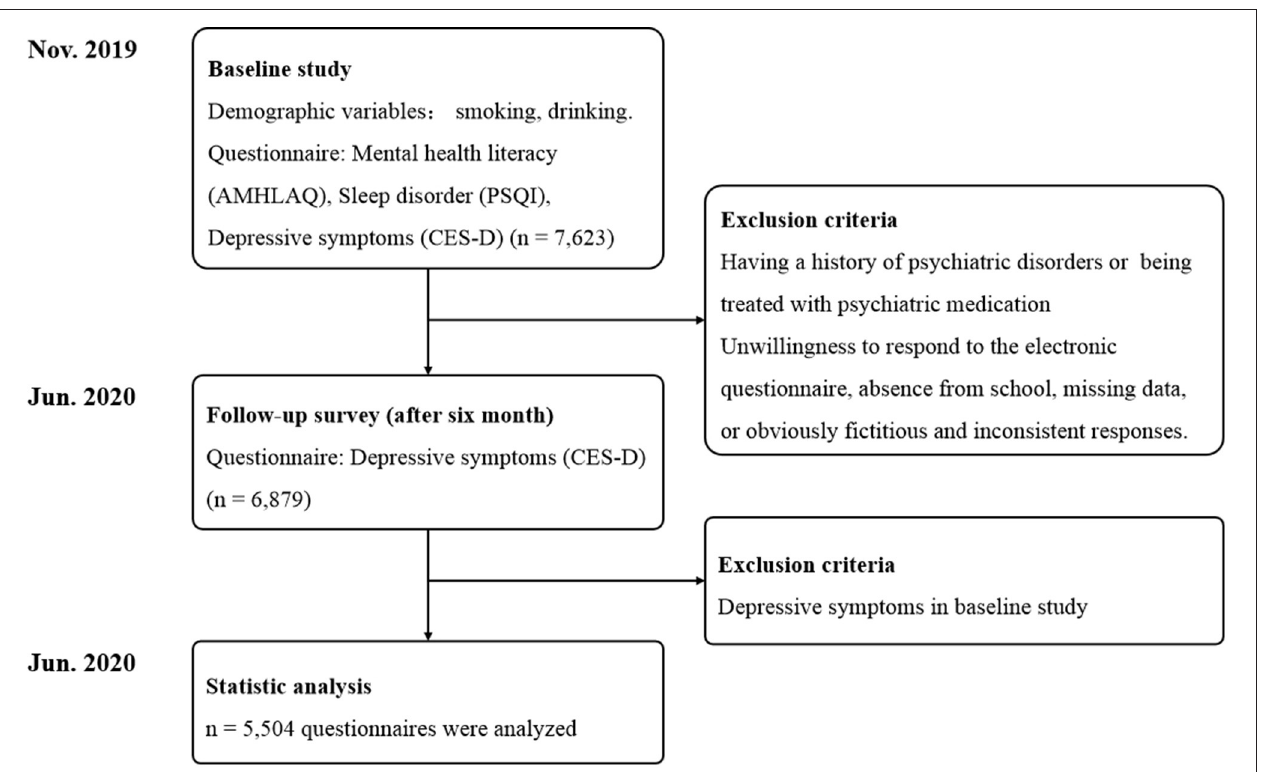
FIGURE 1 | Flow chart of the